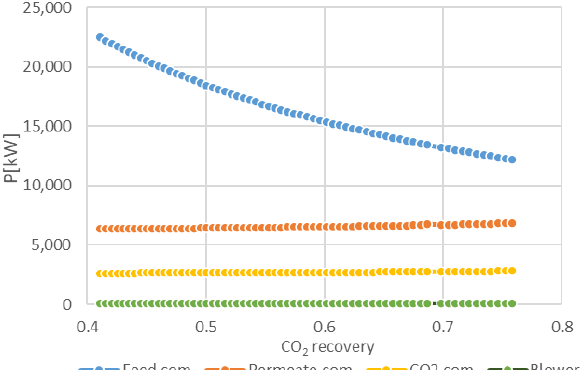
Figure 7. Breakdown of compression power (P) at different overall CO 2 recovery (at p feed = 5 bara, p perm = 0.3 bar, 2nd stage CO 2 recovery 0.7).